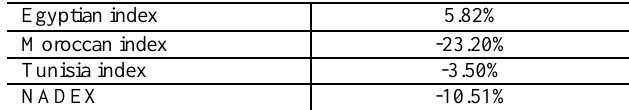
Table 2: North Africa – historical returns of indices for